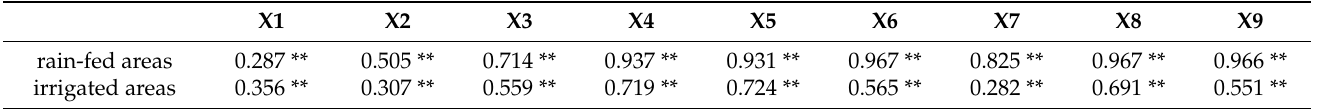
Table 2. PD values of meteorological factors (X1–X8 represent atmospheric pressure, sunshine, relative humidity, water vapor pressure, temperature, precipitation, wind velocity, and mean maximum temperature) and various winter wheat growth stages (X9) in rain-fed and irrigated areas. X1 X2 X3 X4 X5 X6 X7 X8